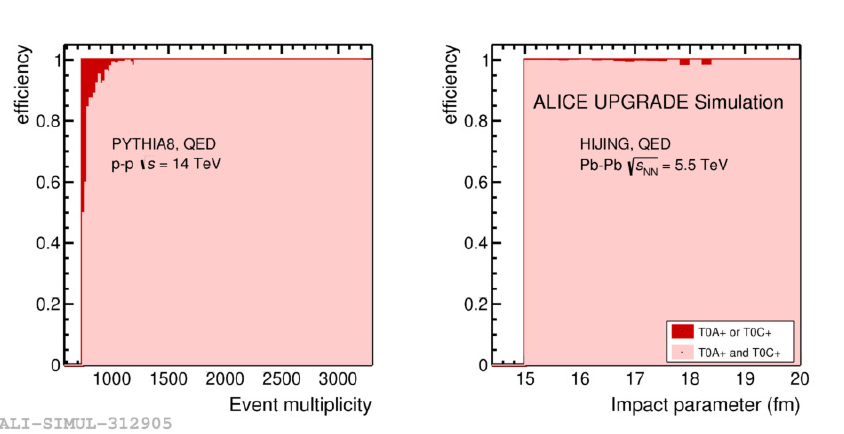
Figure 3. MB trigger e ffi ciency measured by the FIT detector for pp (left) and Pb–Pb (right) collisions